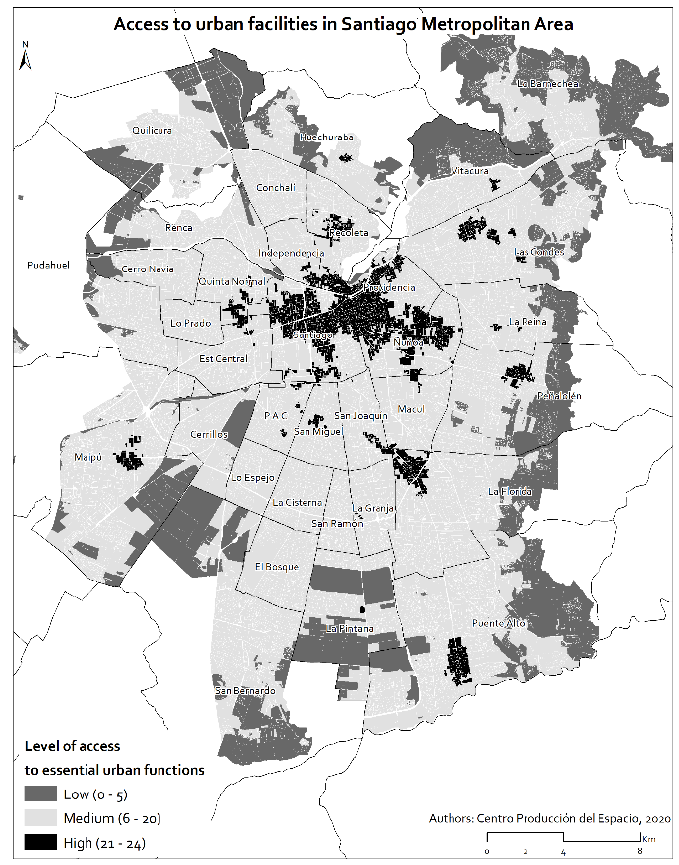
Figure 7. Access to Essential Urban Functions in the Santiago Metropolitan Area. Source: authors.